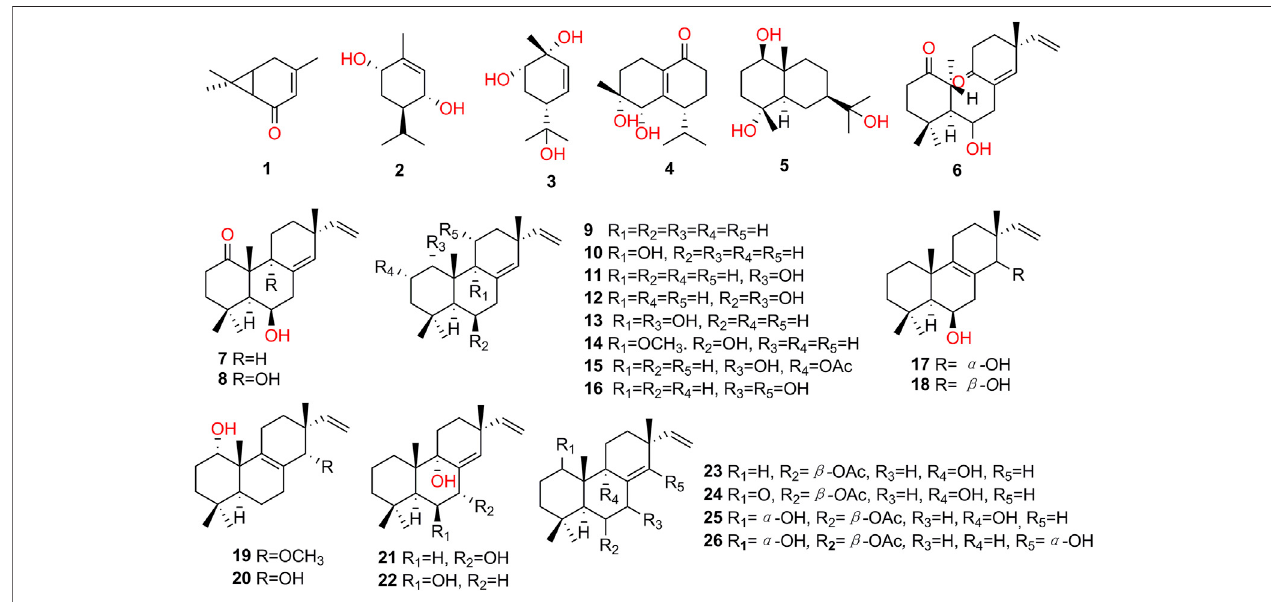
FIGURE 3 | Structures of terpenoids isolated from K. galanga .